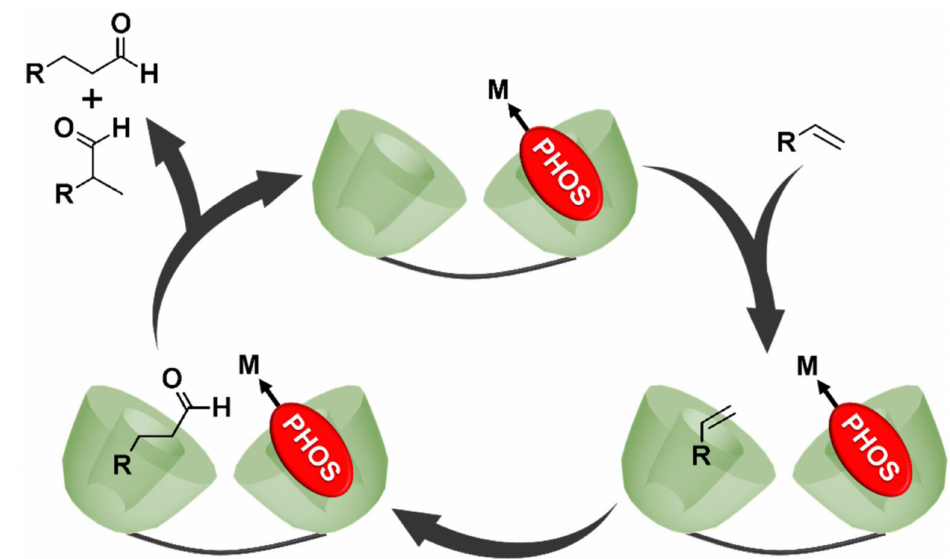
Figure 15. A CD dimer as a supramolecular reaction platform for hydroformylation.